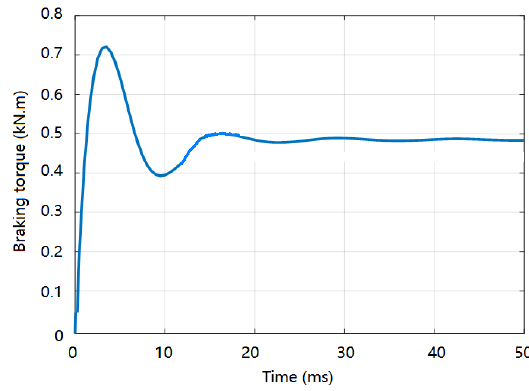
Figure 15. Braking torque curve at 1000 r/min.